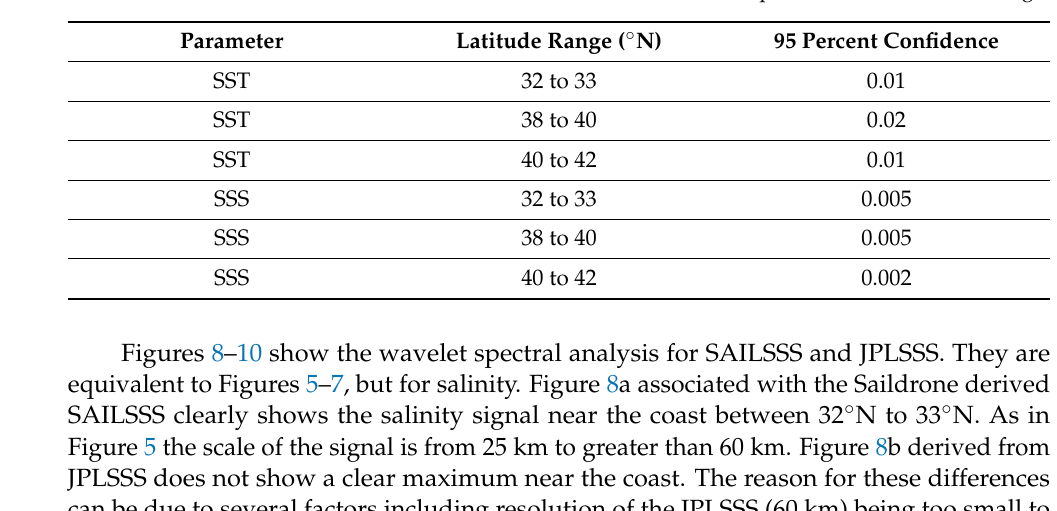
Figure 7. ( a , b ). Wavelet spectra from 40°N to 42°N for ( a ) SAILSST and ( b ) MURSST. Arrows indi- Figure 7. ( a , b ): Wavelet spectra from 40 ◦ N to 42 ◦ N for ( a ) SAILSST and ( b ) MURSST. Arrows indicate cate the color associated with the 95% level of confidence. the color associated with the 95% level of confidence. Table 2. Shows the 95% confidence value for the SST and SSS wavelet spectra for each latitude